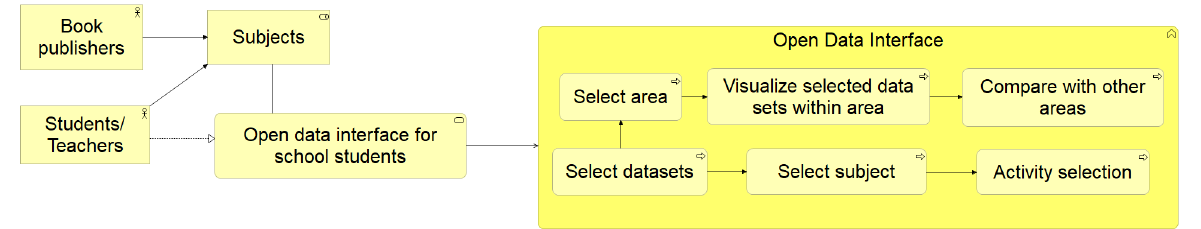
Figure 9. Open Data web interface for Open Data usage in schools (business layer